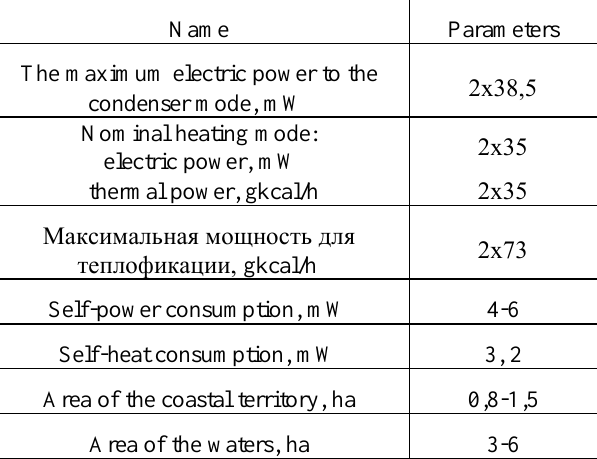
Table 1. Main characteristics of low power atomic thermal power